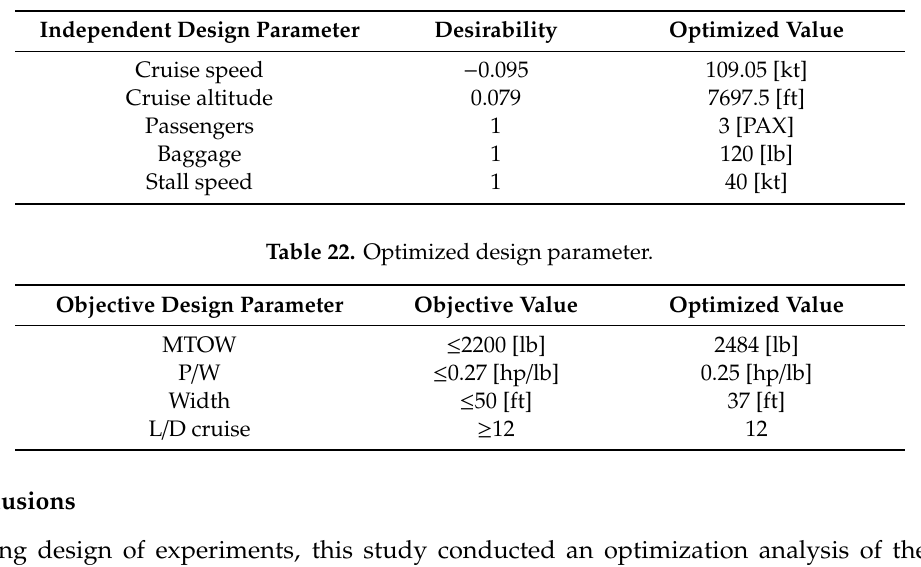
Table 21. Desirability function.